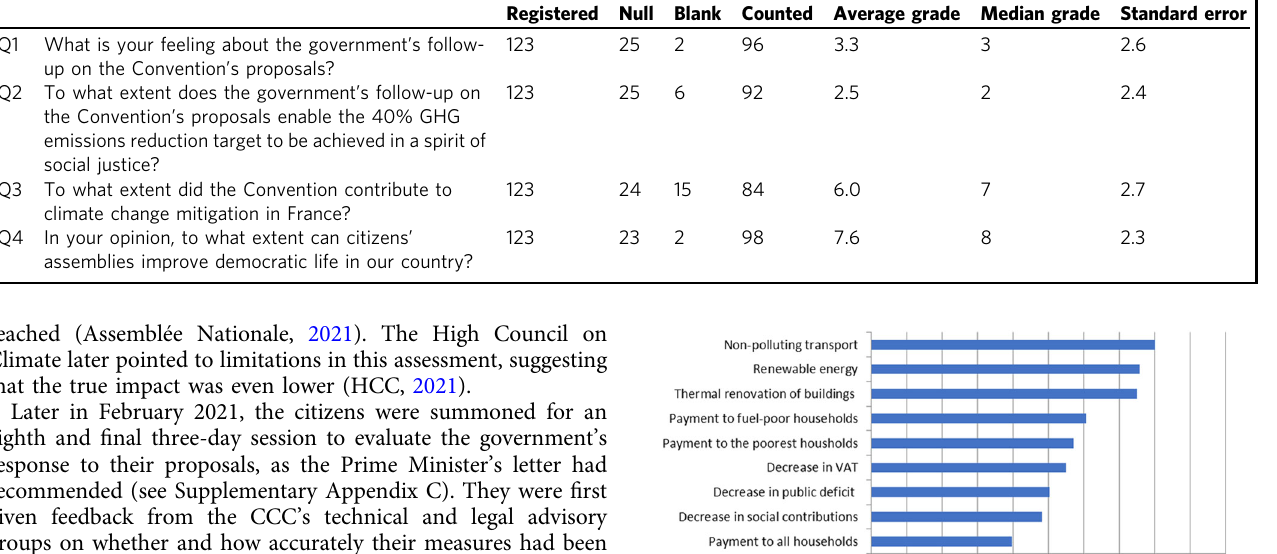
Table 4 Voting results for the four general questions posed in Session 8.